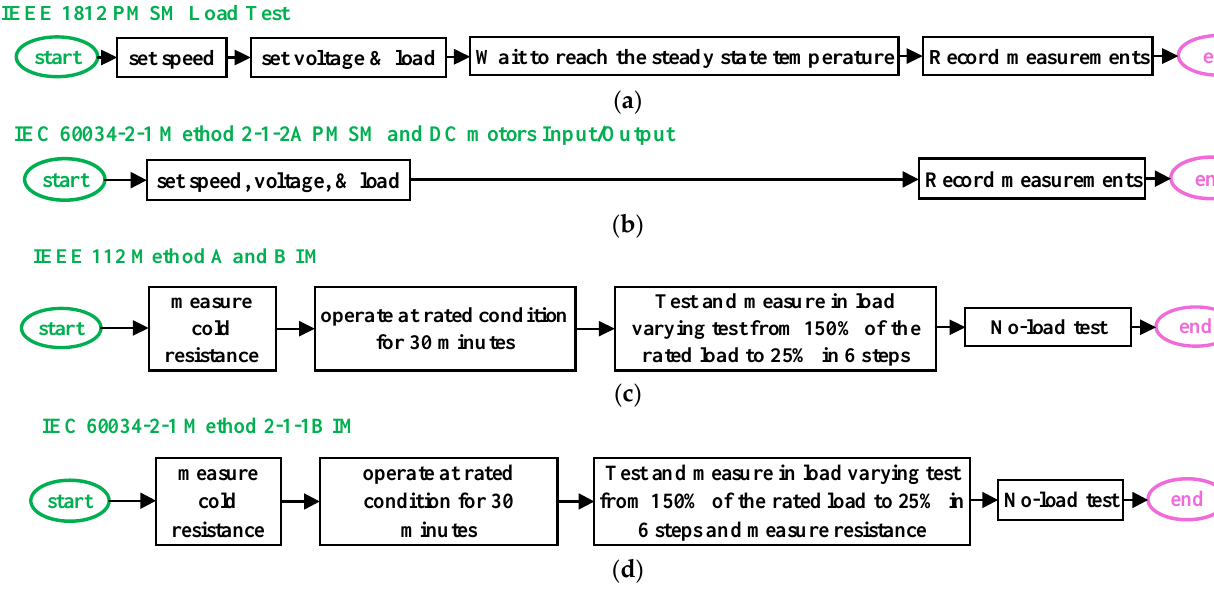
Figure 12. The conventional methods for the extraction of the motor’s efficiency experimentally based on IEEE and IEC standards. ( a ) the procedure of the calculation of the efficiency at a certain load and speed for PMS motors based on IEEE standard. ( b ) the procedure of the calculation of the efficiency at a certain load and speed for PMS and DC motors based on IEC standard. ( c ) the procedure of the calculation of the efficiency at a certain load and speed for the induction motors based on IEEE standard. ( d ) the procedure of the calculation of the efficiency at a certain load and speed for the induction motors based on IEC standard.